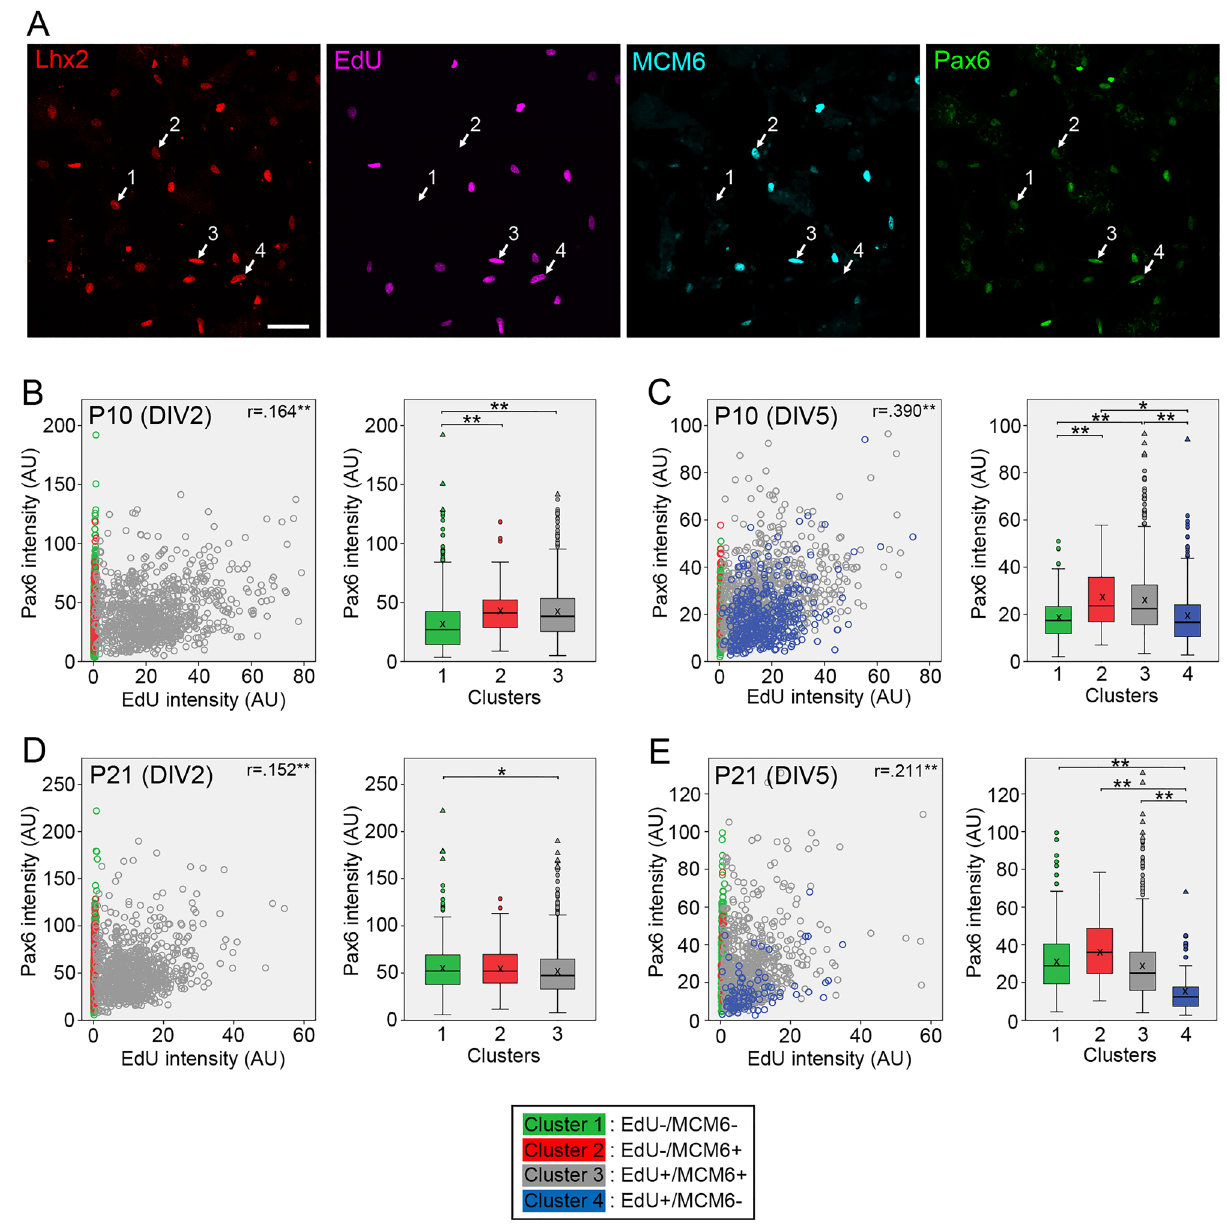
Figure 4. Quantitative analyses of Pax6 expression in Müller glia dissociated from P10 and P21 mouse retinas. Intensities of EdU, MCM6 and Pax6 labeling in Lhx2 + Müller glia were quantitated by image analysis. Pax6 levels in Müller glia classified into four clusters are shown as scatter plots and box plots. ( A ) Confocal images of quadruple labeling for Lhx2, EdU, MCM6 and Pax6 in Müller glia from P10 retina at DIV5. The numbers represent the clusters. Scale bar = 50 µm. ( B ) Plots of 2138 Müller glia from P10 retina at DIV2. ( C ) Plots of 1700 Müller glia from P10 retina at DIV5. ( D ) Plots of 1895 Müller glia from P21 retina at DIV2. ( E ) Plots of 1118 Müller glia from P21 retina at DIV5. AU arbitrary units. r , Spearman’s correlation coefficients between Pax6 and EdU intensities in the cluster 3. X in box plots indicates the mean. * P < 0.05, ** P <